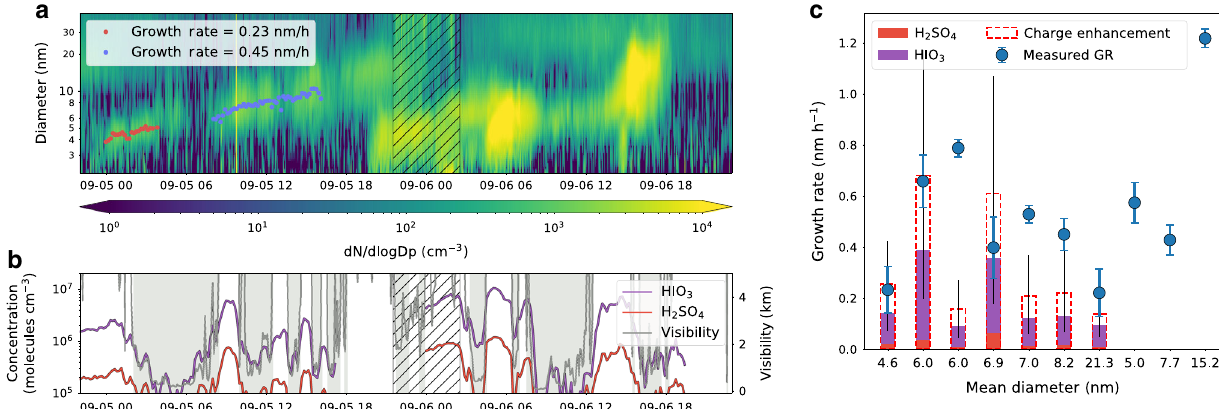
Fig. 3 Ultra fi ne particle growth and losses. a Particle size distribution (PSD) measured with a neutral cluster and air ion spectrometer (NAIS) with the indication of the fi tted mode diameter used for growth rate calculation. The black hatched region indicates a period in fl uenced by pollution from the ship. b Concentrations of iodic and sulfuric acid together with visibility. Grey shaded areas indicate fog periods. c Growth rate (GR) measurements for the entire campaign as a function of the mean diameter mode during the event. The blue marker shows the measured growth rate obtained by fi tting the mode diameter (the error bars represent the 95% con fi dence intervals from the fi tted slope). The bar plot shows the estimated growth rate based on the mean mode diameter and the concentration of sulfuric and iodic acid 44 . The black lines are the error bars due to the uncertainty of sulfuric and iodic acid concentration. The red dashed bars show the predicted growth rate when considering also the charge enhancement factor (EF) derived from Stolzenburg et al. 45 Since for the last three events iodic and sulfuric acid measurements are not available, we report only the measured growth